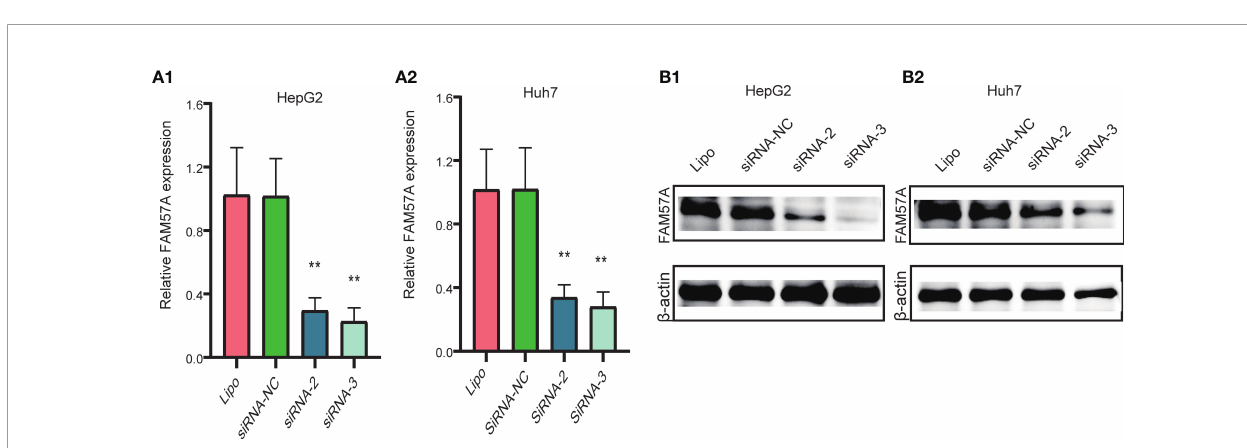
FIGURE 9 | Detection of FAM57A knockdown ef fi ciency. (A1, A2) qRT-PCR assay for HepG2 and Huh7 cells, respectively. (B1, B2) Western blotting analysis in HepG2 and Huh7 cells, respectively. **p < 0.01 compared to Lipo and siRNA-NC. Lipo, Lipofectamine